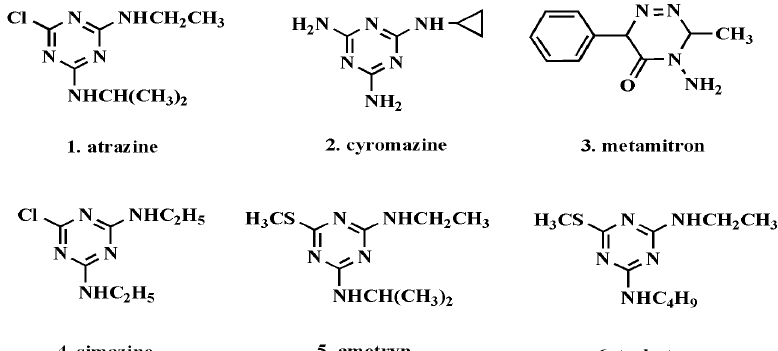
Figure 6. Molecular structure of six analytes for the specificity